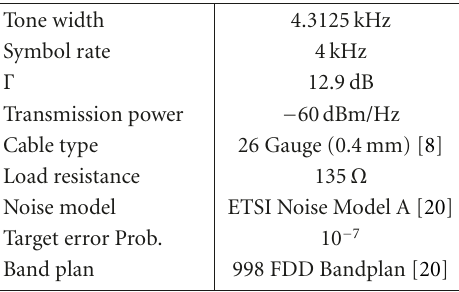
Table 1: Simulation